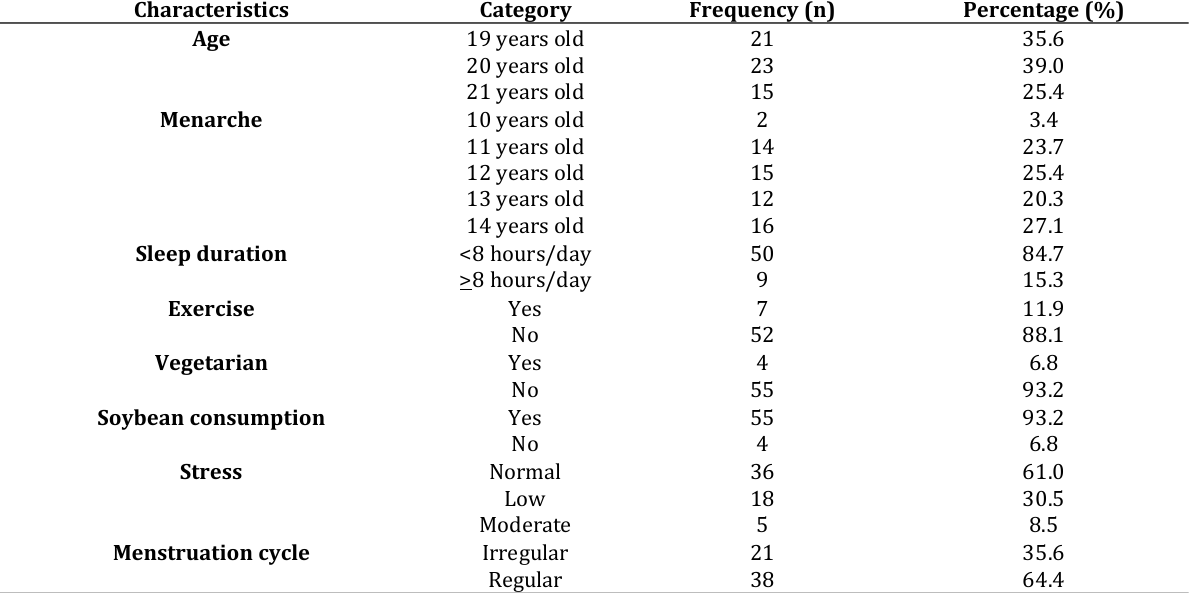
Table 1. The Distribution for Characteristics of Participants (n= 59) Characteristics